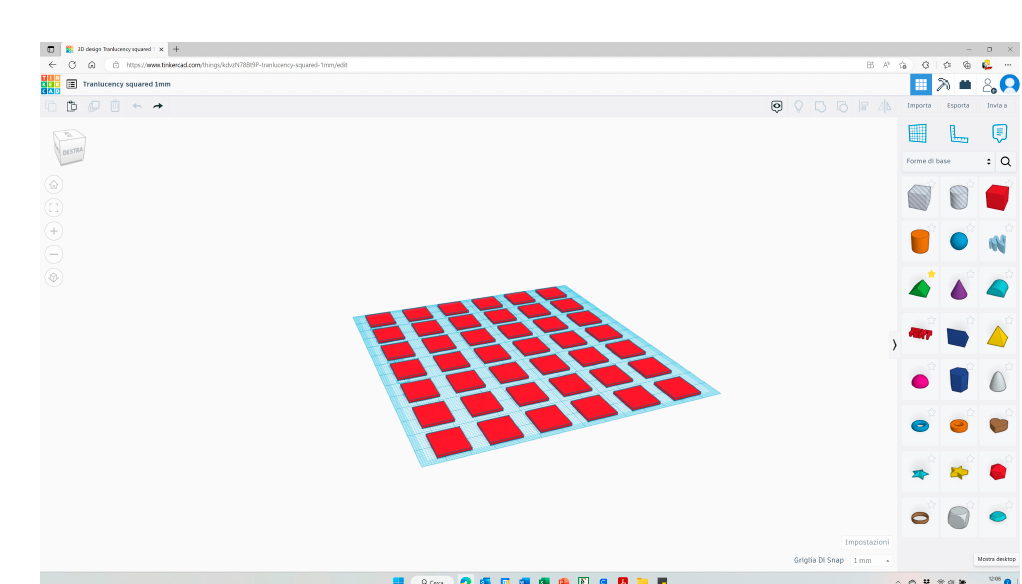
Figure 2. Specimens with a dimension of 14 mm × 14 mm and a thickness of 1.0 mm were designed using Thinkercad software.